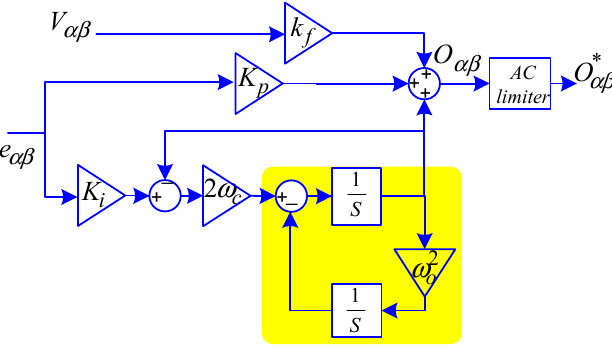
Figure 12. Block diagram of PR controller with two integrators.